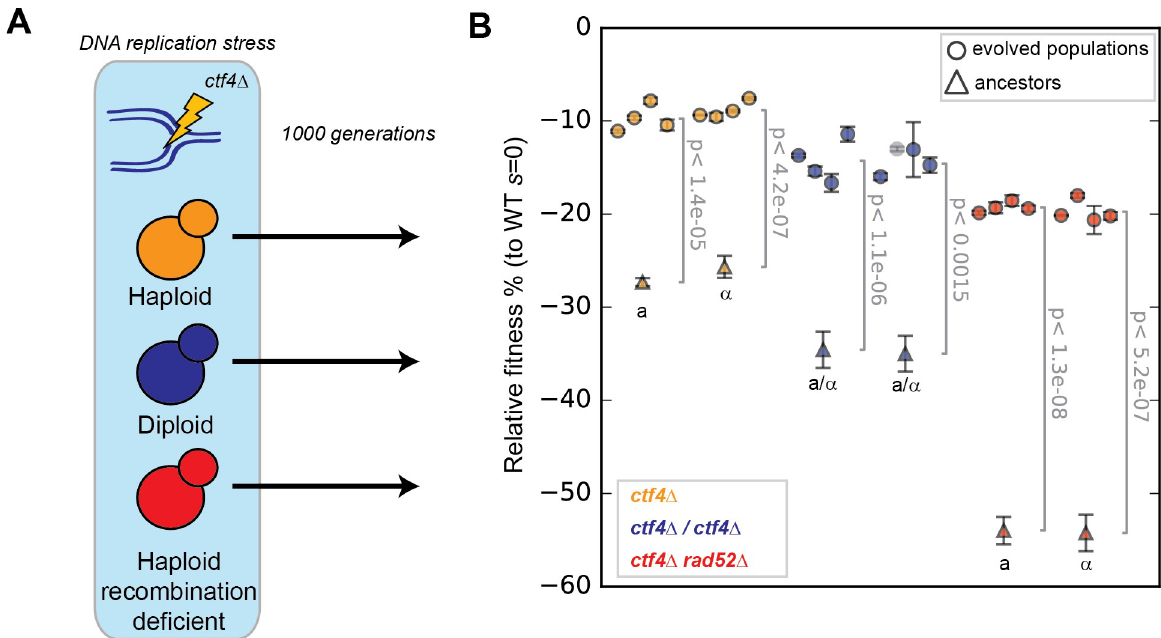
Fig 1. Evolutionary adaptation to constitutive DNA replication stress in strains with different genomic features. (A) Experimental scheme: Constitutive DNA replication stress was induced by removing Ctf4, a protein that coordinates replisome activities. Haploid (orange), diploids (blue) and cells with a severely decreased ability to perform homologous recombination (red, recombination-deficient), were subjected to 1000 generations of experimental evolution in the presence of constitutive DNA replication stress. (B) The fitness of the 6 ancestral strains (2 for each genome architecture) and of 24 evolved populations derived from them, relative to WT cells ( s = 0). Cells were competed against reference strains with the same ploidy. Fitness data of haploid strains (orange) is from [17]. The semi-transparent gray dot represents a diploid strain that became haploid during the experiment and is thus excluded from subsequent analysis. Error bars represent standard deviations. a and α refer to the strains’ mating type ( MAT locus). a/ α indicates diploid strains. The P-values reported in figures are the result of t-tests assuming unequal variances (Welch’s test). The fitness values shown here are reported in S1